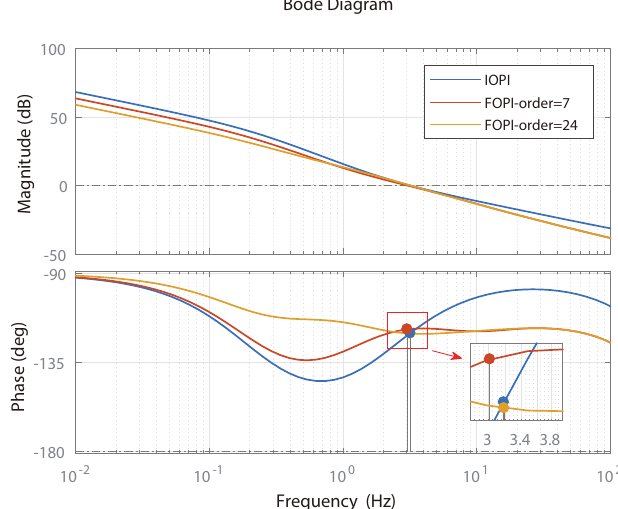
Figure 10. Open − loop Bode plot with the different controllers.